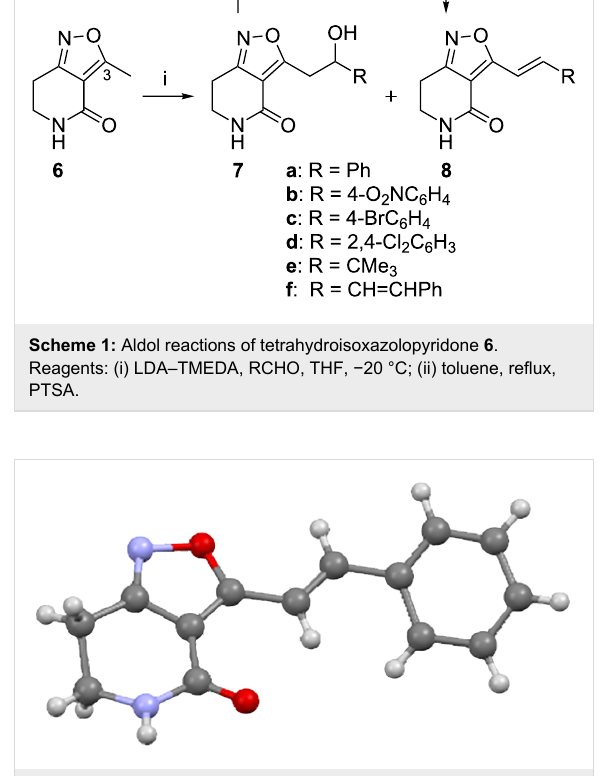
By using the same protocol, the reaction was repeated with 4-nitrobenzaldehyde to afford 8b (52%). 4-Bromobenzalde- hyde gave condensation product 8c (15%) with